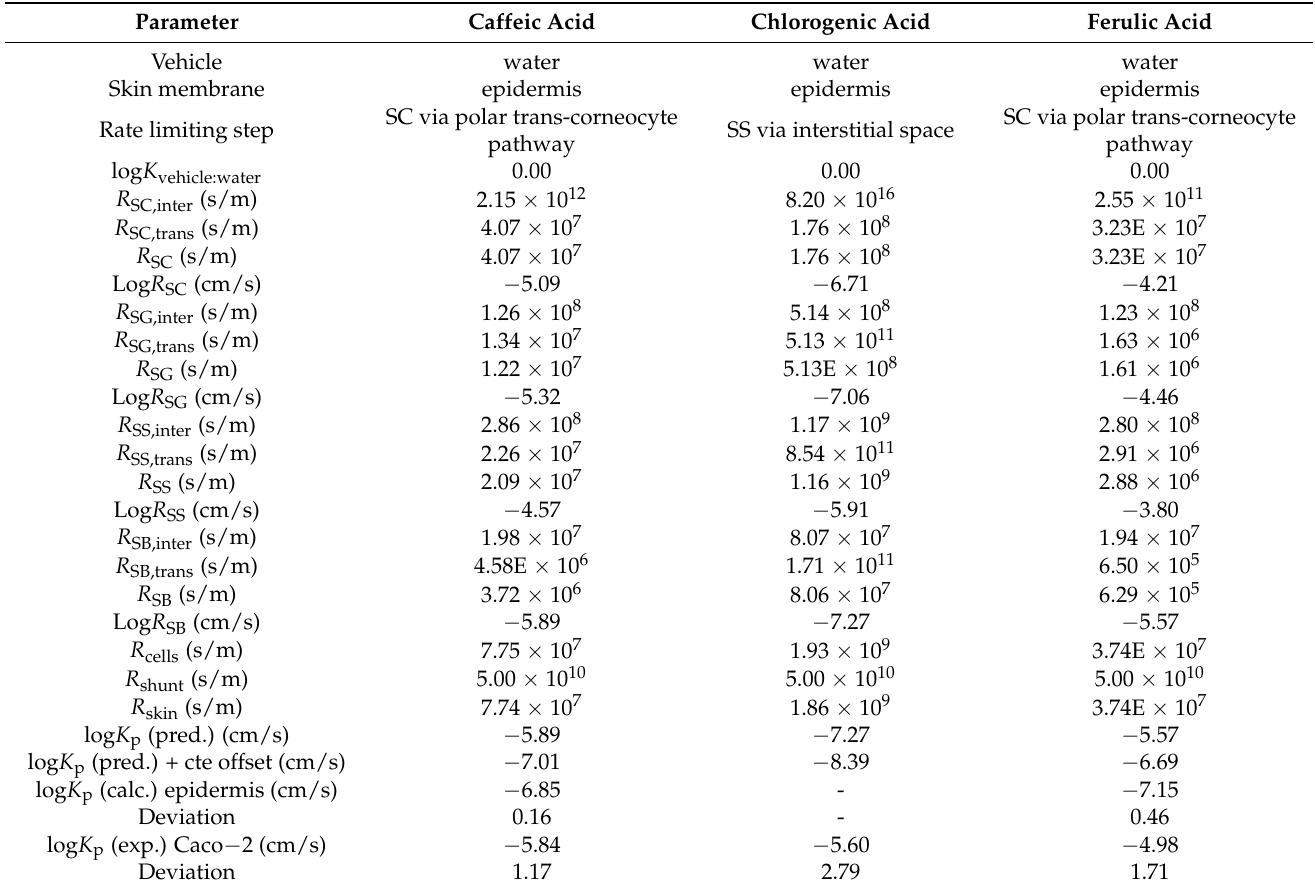
Table 5. Detailed model parameters of resistances and and K p (predicted, calculated, experimental and their deviations) for CAF, CHA and FA for each compartment and their permeation